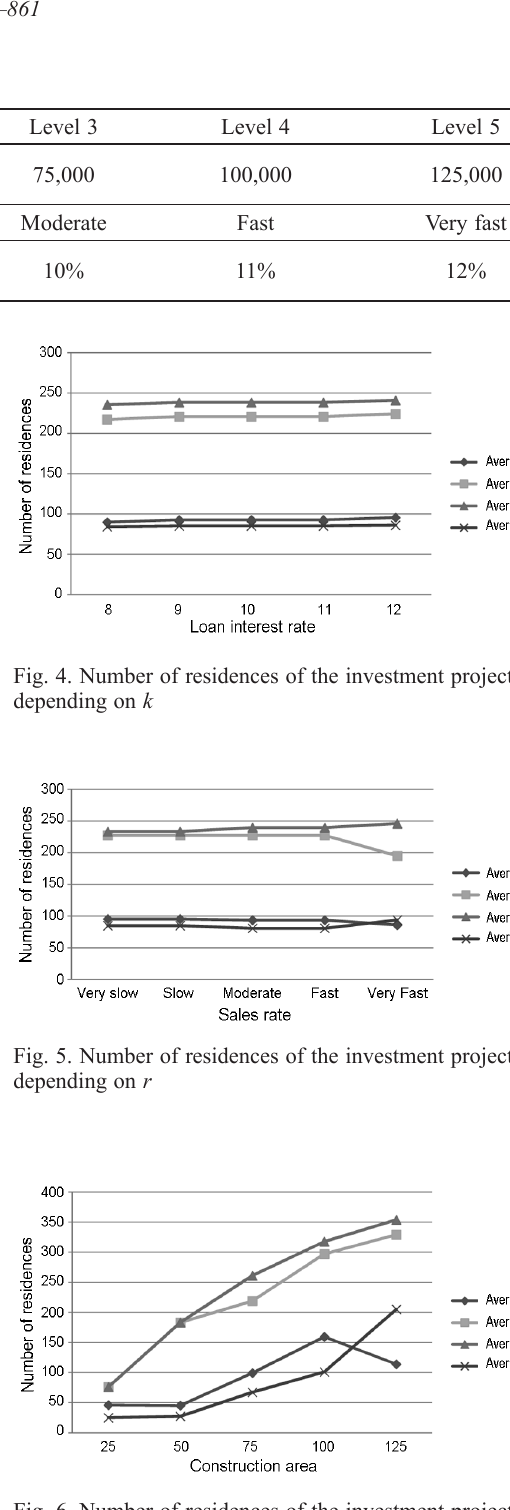
Fig. 6. Number of residences of the investment project depending on